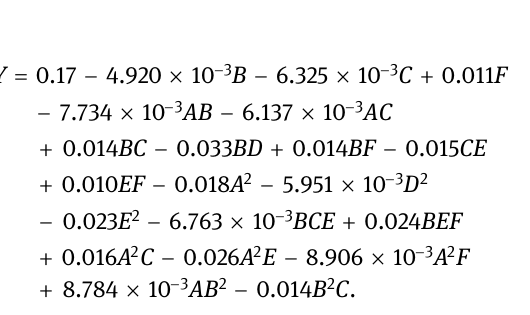
The value of the coe ffi cient of determination “ R - squared ” represents the quality of the polynomial model equation fi tting. The higher the R - squared, the more con - sistent the model is with the experimental data. The ( 2 ) results show that R - squared is 0.9156, which is close to 1, indicating that the thermal conductivity of the experi - ment can be explained by the fi tting model equation under the condition of 91.56% variability. The model analysis after adjustment is shown in Figure 5. It can be seen from Figure 5 ( a ) that the experi - mental data and predicted values are basically distri - buted along a straight line, which indicates that the di ff erence between the predicted value and the real value is small. Figure 5 ( b ) is the normal distribution table of the residuals. The experimental residuals are distributed along a straight line, which shows that the experiment has good accuracy. Figure 5 ( c ) shows the relationship between the residual and the predicted heating rate. The distribution of data points is scattered and irregular, which indicates that the model can predict the experi - mental results more accurately in theory. As can be